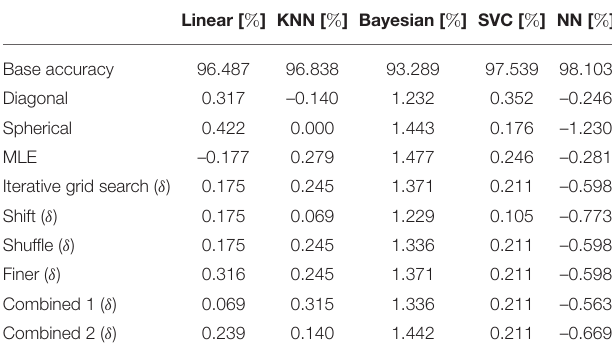
TABLE 6 | Improvement δ in accuracy for different iterative optimization settings on 2-dimensional subsets of the sonar dataset.